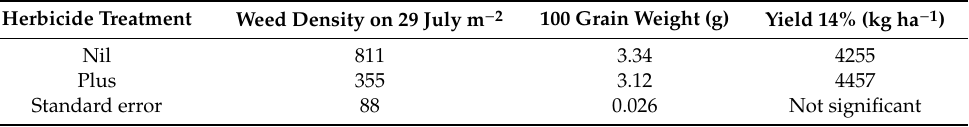
Table 8. E ff ect of post-emergence herbicide on rice yield components in